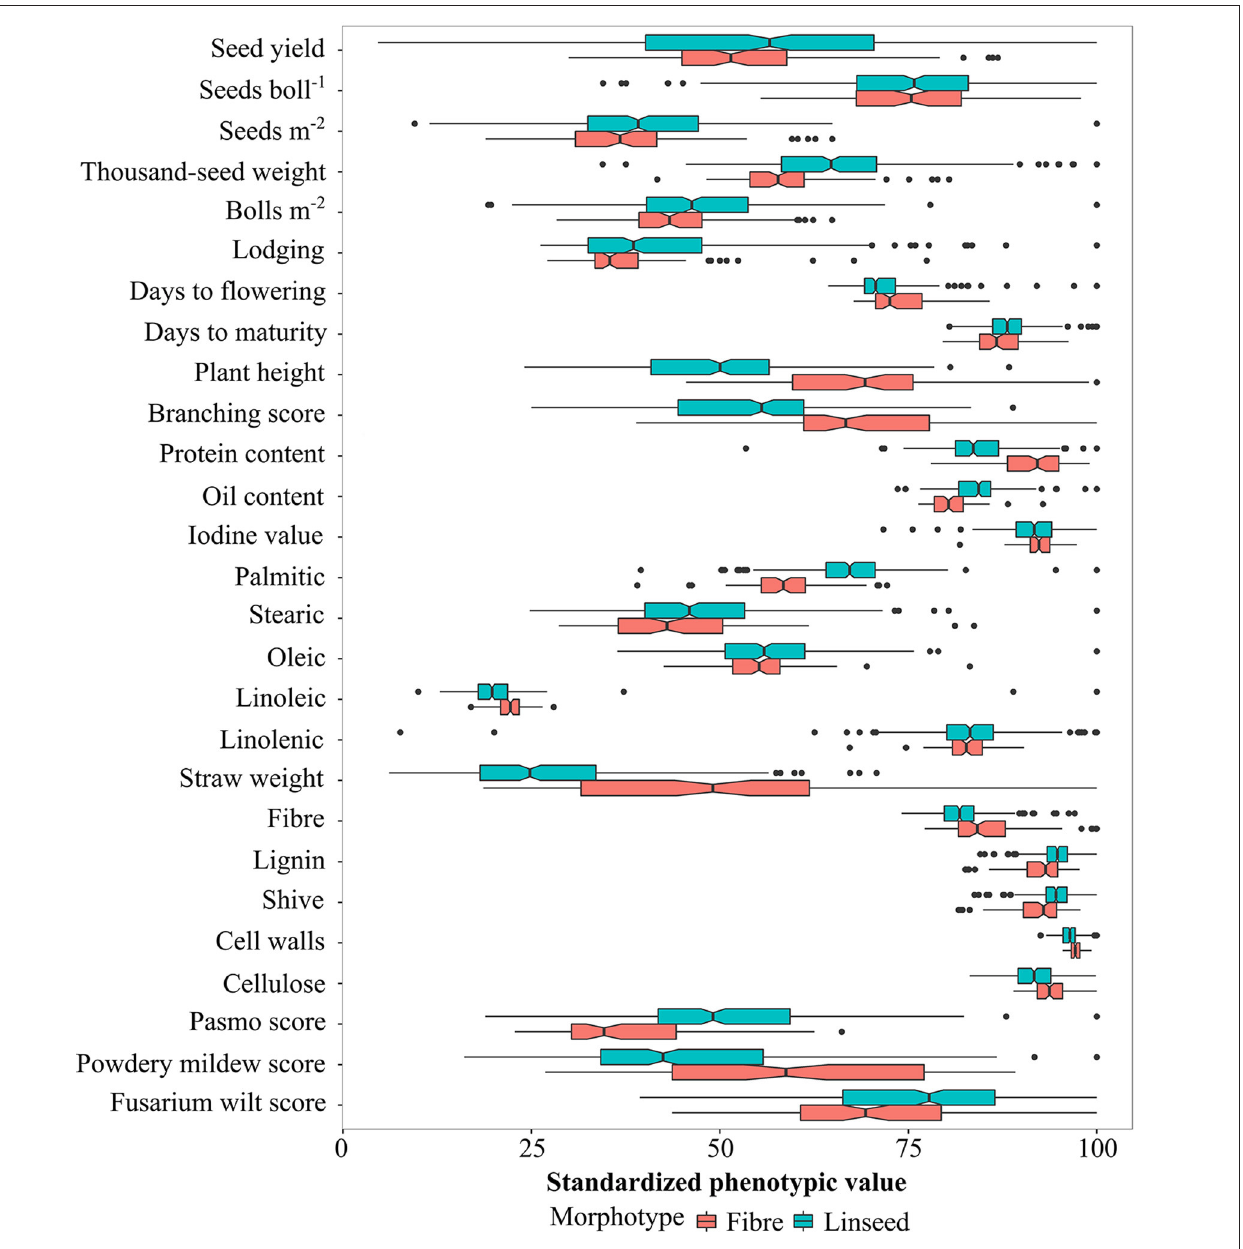
FIGURE 3 | Graphical comparison of variation in linseed and fiber types for 27 traits. The absolute values (see Table S6) have been standardized as percentages of the maximum value of each trait. Statistical significance between linseed and fiber types at the 0.05 probability level is indicated with notched boxes. Box notches that do not overlap indicate median differences between fiber and linseed accessions at a 95% confidence